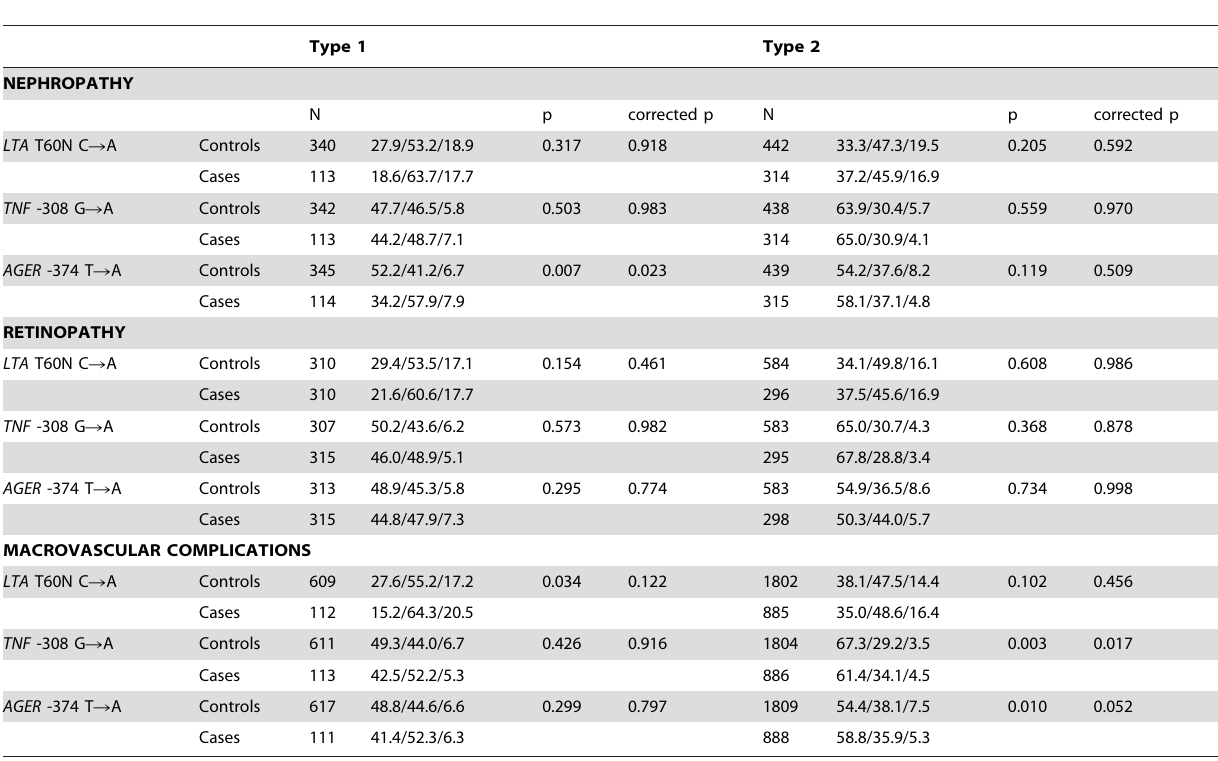
Table 4. Allelic association of LTA T60N (C R A), TNF -308G R A and AGER -374 T R A polymorphism with diabetic nephropathy, retinopathy and macrovascular